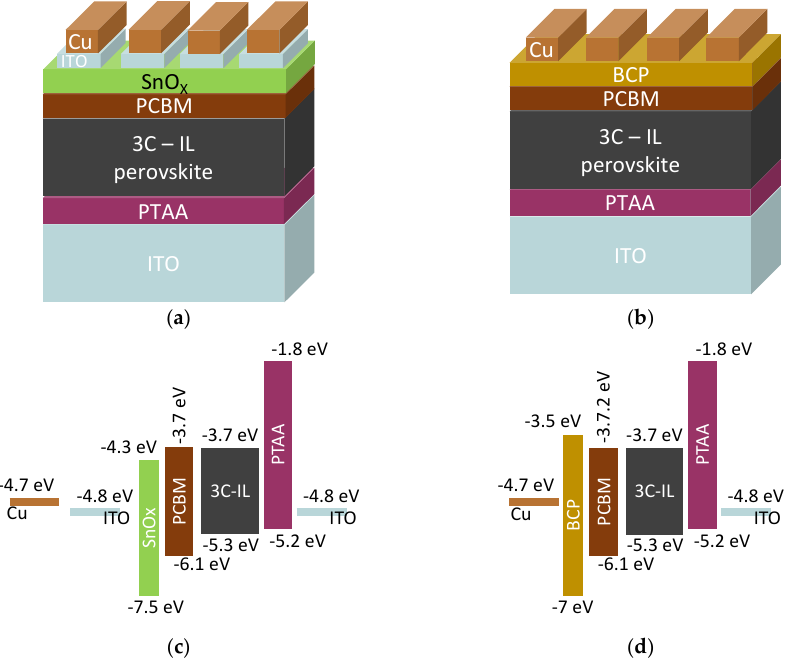
Figure 1. Architecture of the solar cells used in this work: These perovskite solar cells are based on a triple cation perovskite layer with nominal composition Cs 0.05 FA 0.81 MA 0.14 PbI 2.7 Br 0.3 along with BMIM-BF 4 ionic liquid additives, labeled as 3C-IL ( a ) SnO X is used as a hole-blocking layer; ( b ) BCP is used as a hole-blocking layer; ( c ) and ( d ) are the qualitative band diagram for the SnO X and BCP architectures, respectively.